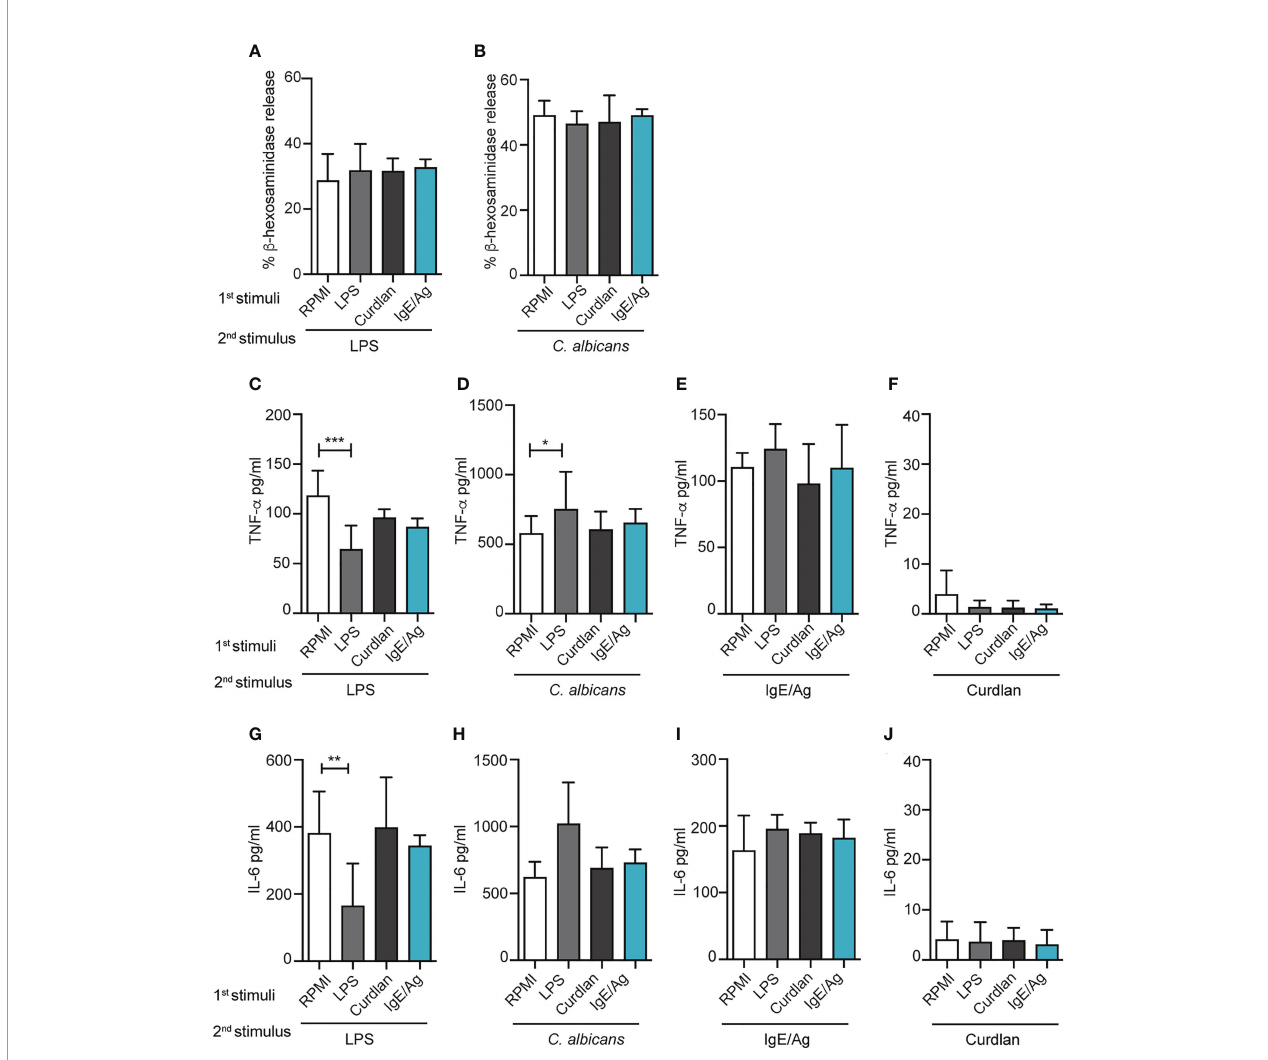
FIGURE 2 | Effect of different priming on MC degranulation and cytokine release response to a secondary challenge. Degranulation of BMMCs primed with LPS (1mg/ml), curdlan (100mg/ml), IgE/Ag or RPMI was determined 6 days after cell recovery as percentages of released b -hexosaminidase in response to 30 min of stimulation with IgE/Ag (A) or ionomycin (B) . BMMC primed with RPMI, LPS (1mg/ml), curdlan (100mg/ml) or IgE/Ag were subjected to a second stimulation with LPS (C – G) , live C. Albicans (D – H) , IgE/Ag (F – I) or curdlan (E – J) . TNF- a (C – F) and IL-6 (G – J) levels were detected in culture supernatants after 24 hours. Data are expressed as mean +SD from n>4 experiments; statistical analysis were performed with one-way Anova with Dunnet correction (*p < 0,05 **p < 0,01; ***p <